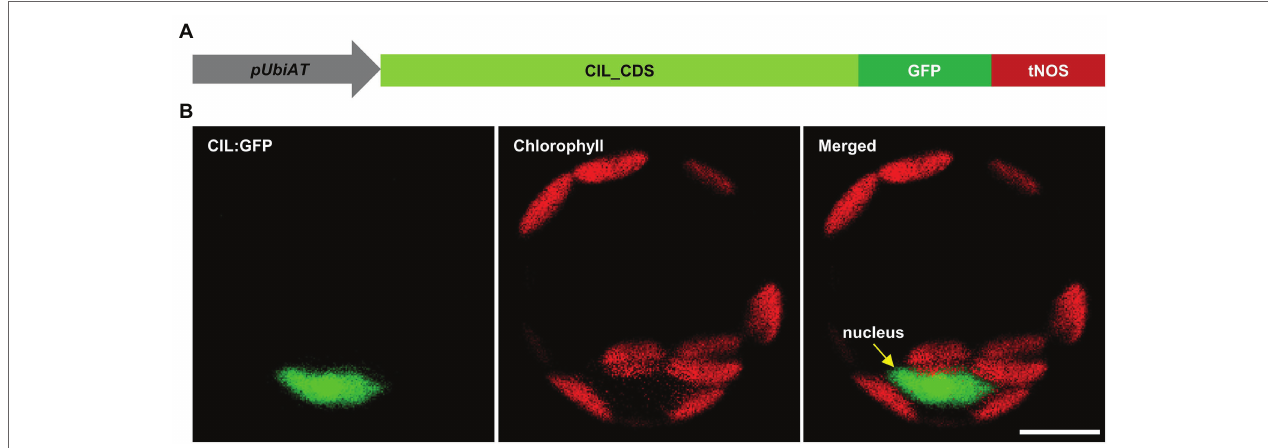
FIGURE 3 | Subcellular localization of CIL:GFP fusion protein. (A) Schematic drawing of the construct used for protoplast transformation. pUbiAT , Arabidopsis Ubiquitin 10 promoter; CIL_CDS, coding sequence of the CIL gene; GFP, green fluorescent protein; tNOS, Agrobacterium tumefaciens NOPALINE SYNTHASE terminator. The drawing is not in proportion with gene length. (B) Subcellular localization of the CIL:GFP fusion protein in Arabidopsis protoplasts. Green and red colors are assigned to GFP and chlorophyll fluorescence, respectively. The yellow arrow in the merged panel indicates the nucleus. Scale bar, 10 μ